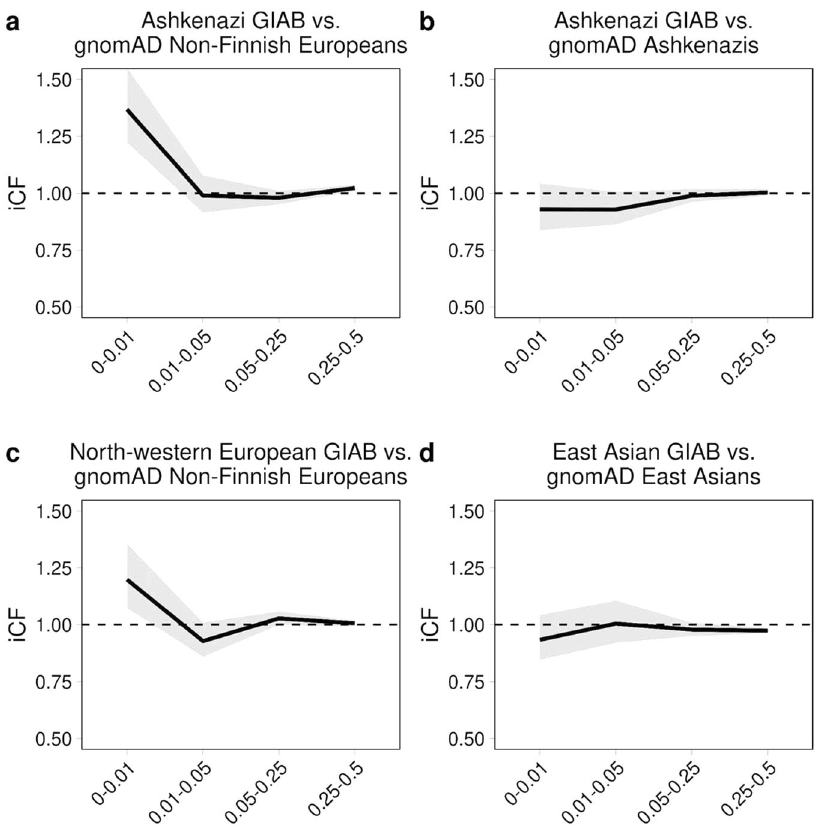
Fig. 3 Comparison of iCF values for consensus GIAB samples strati fi ed by allele frequency bin. Ethnic comparisons include the Ashkenazi GIAB sample (NA24385) with gnomAD Non-Finnish Europeans and gnomAD Ashkenazis ( a , b , respectively), the North-western European GIAB sample (NA12878) with gnomAD Non-Finnish Europeans ( c ), and the East Asian GIAB sample (NA24631) with gnomAD East Asians ( d ). iCF values were calculated as the exome-wide ratio of the sum of per-individual observed allele counts (OAC) to the sum of per-individual expected allele counts in gnomAD (EAC) according to Eq. (5) for all exonic alleles. Allele frequency bins were chosen to best stratify variants according to rare [0 – 0.01], low-frequency [0.01 – 0.05], common [0.5 – 0.25] and very common [0.25 – 0.5] bins. Allele frequencies were standardized to the minor allele. All shaded regions depict the 95% con fi dence interval of the iCF at each AF bin. Dashed lines indicate an iCF representing equal total allele counts between the GIAB sample and gnomAD (i.e., iCF = 1) across all protein-coding genes. iCF indicates individual correction factor, and GIAB indicates Genome In A Bottle, and gnomAD indicates genome aggregation database. Equations are de fi ned in the “ Methods ” section. Source data are provided as a Source data fi